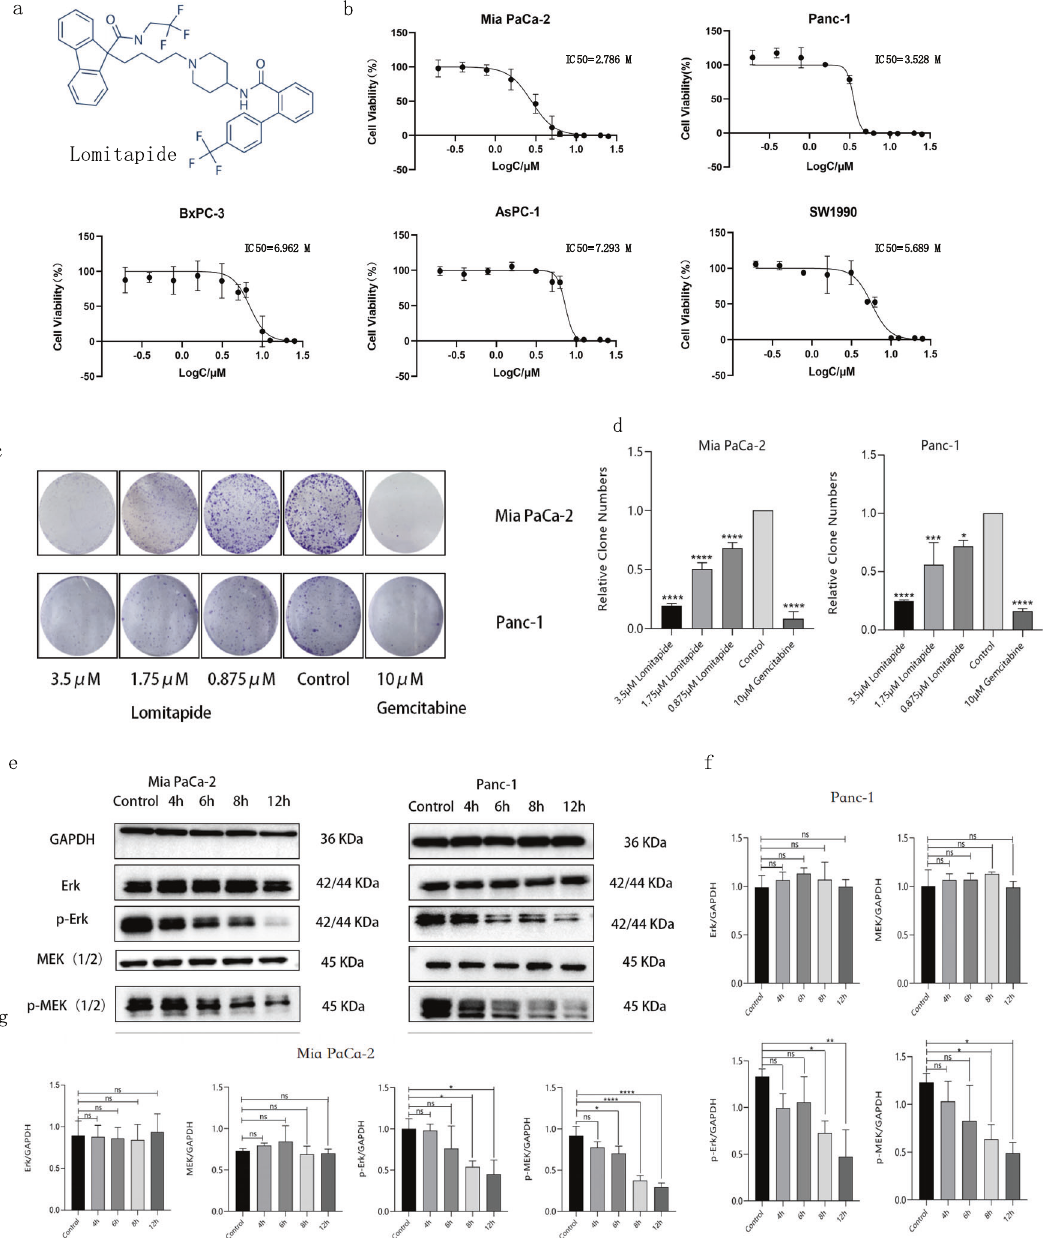
Fig. 6 In vitro evaluation of Lomitapide. a Lomitapide structure. b The effects of Lomitapide on fi ve pancreatic cancer cell lines were measured by MTT assay. c , d Treated Panc-1 and Mia Paca-2 cells with 3.5 μ M, 1.75 μ M, and 0.875 μ M of Lomitapide, as well as blank group and positive control (Gemcitabine HCL, 10 μ M), and found that Lomitapide signi fi cantly inhibited the colony formation of these two cell lines in a dose-dependent manner. e – g We extracted proteins from Mia PaCa-2 cells and Panc-1 cells 4 h, 6 h, 8 h and 12 h after administration respectively for Western blotting experiment which showed lomitapide presumably inhibit cell proliferation through p-MEK and p-ERK by inhibiting protein phosphorylation, and the degree of inhibition is time dependent. Data are expressed as mean ± SEM ( n = 3) * p < 0.05, ** p < 0.01, *** p < 0.001 in b , d , f , g Two human pancreatic cancer samples obtained from JIANGSU CANCER HOSPITAL for sc-RNA seq were collected from a woman and a man undergoing surgery for pancreatic cancer patients.